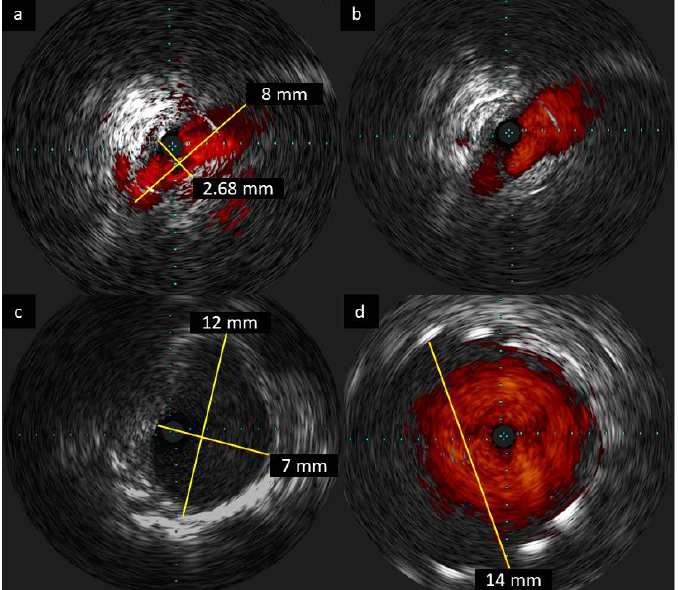
Figure 3. The intravascular ultrasound (IVUS) examination of right segmental A9 / A10 pulmonary artery. Critical stenosis was confirmed in the first BPA session ( a ). The second BPA session revealed elastic recoil phenomenon after the use of increasing diameters (4.0 mm, 7.0 mm, and 8.0 mm) of balloon catheters ( b ). Distal A9 / A10 reference diameter ( c ) for proper stent selection in third BPA session. Final result after 14 × 30 mm stent implantation ( d